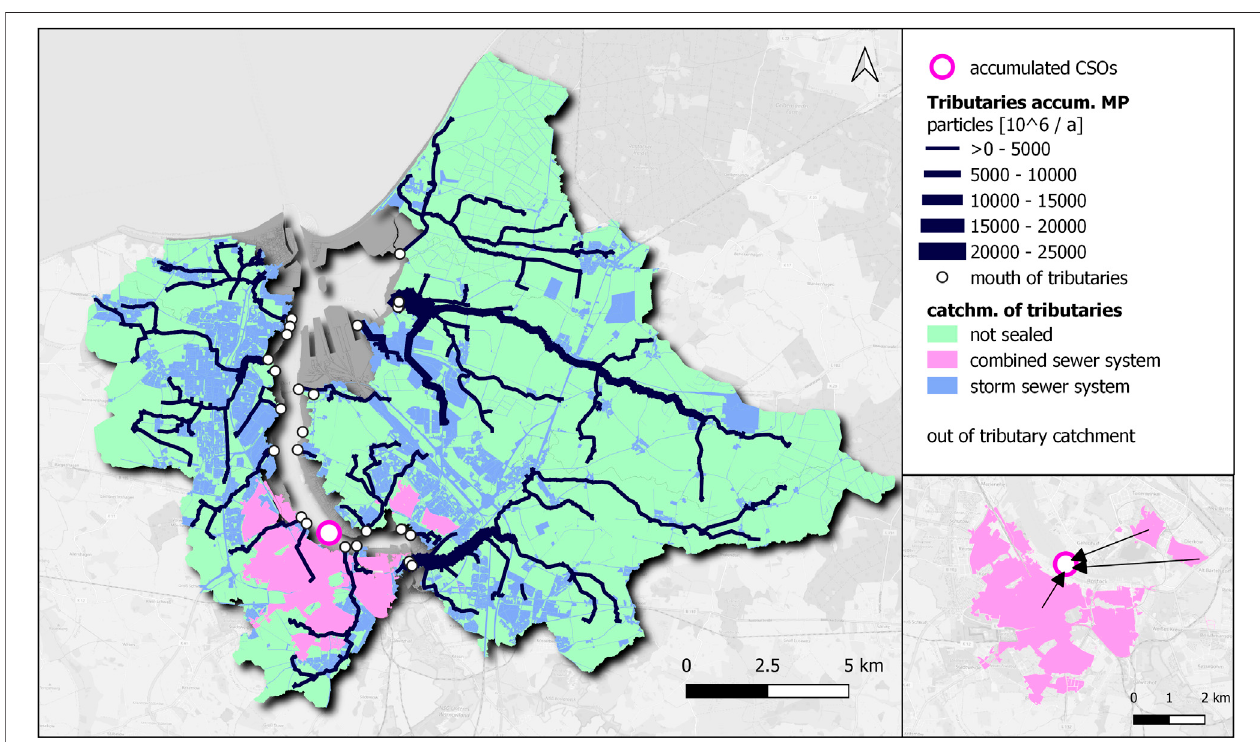
FIGURE 2 | Accumulation of microplastic (MP) emissions from stormwater (blue areas) along tributaries (dark blue lines) within the catchment of the estuary and inputofMPemissionsfromthecombined sewersystem(magentaareas).Greenareasareassumednottobesealedandincludee.g., agriculture,grassland,andparks.